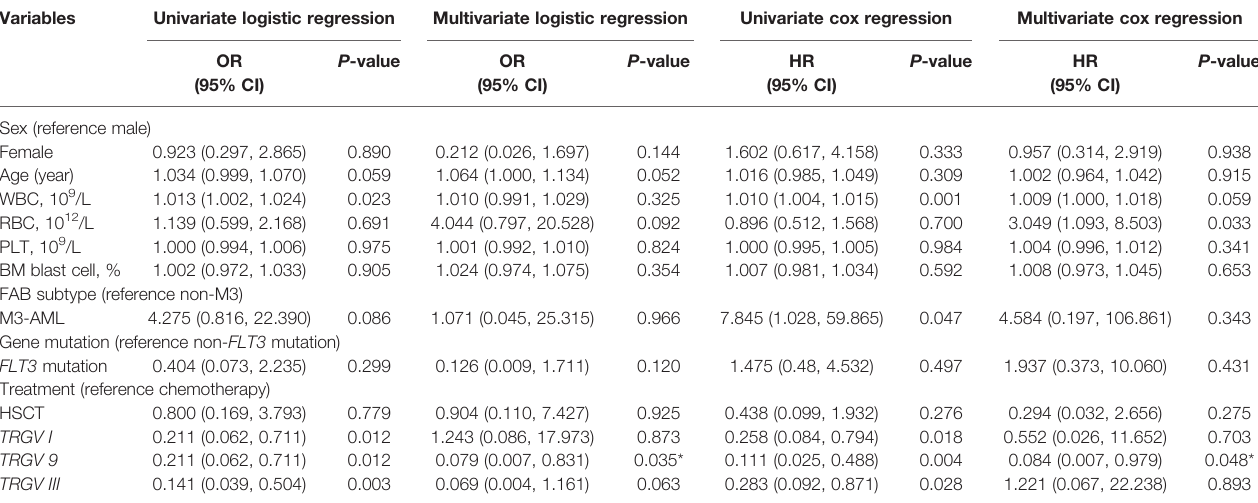
TABLE 3 | Univariate and multivariate logistic and cox regression analysis in AML patients. Variables Univariate logistic regression Multivariate logistic regression Univariate cox regression Multivariate cox